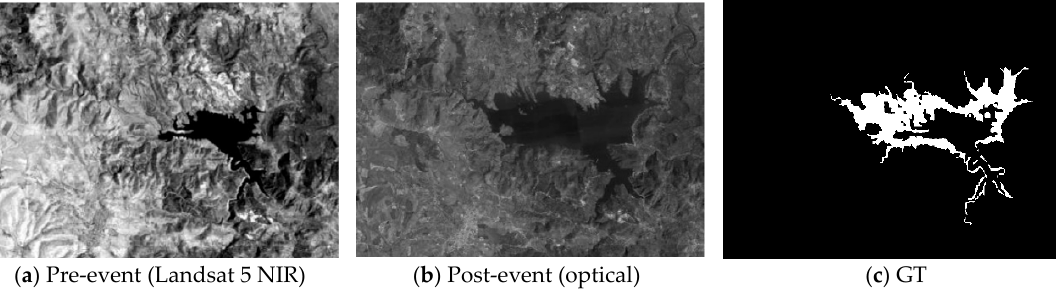
Figure 7. ROC curves for Image Pair-2 without EMAP. Figure 8. ROC curves for Image Pair-2 with EMAP. Table 3. AUC values and differences between single band and EMAP cases for dataset-2. Bold numbers indicate the best performing method in each column. Method